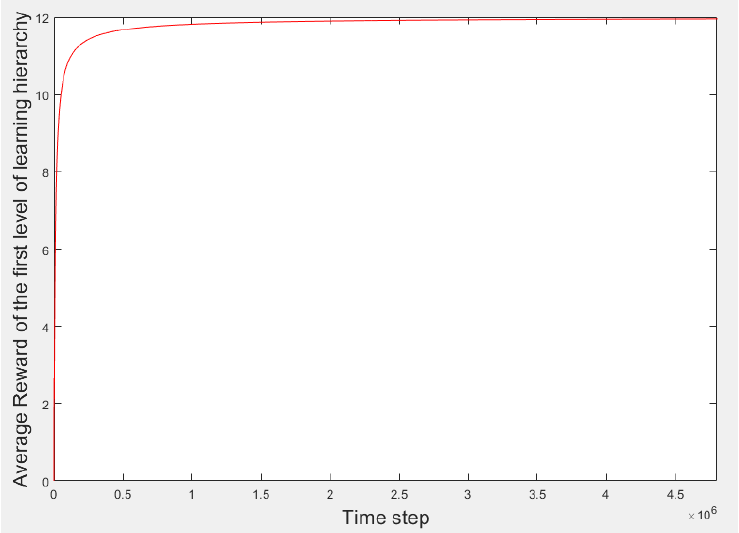
Figure 4. Results of the first learning hierarchy level.